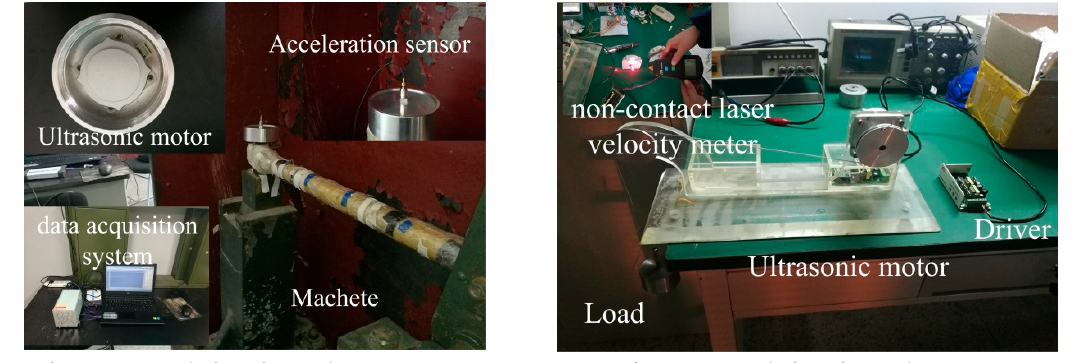
Figure 9. Experiment test platform.